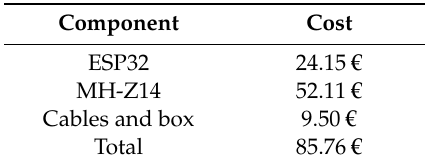
Table 2. Cost of the